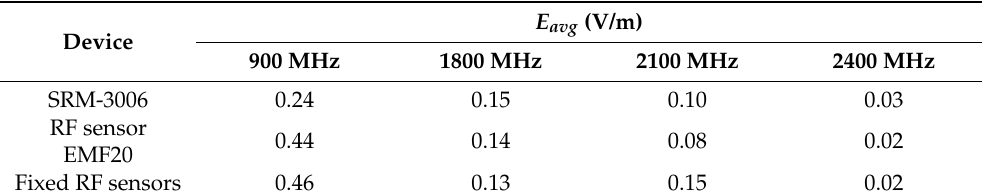
Table A1. Average electric field values measured by three different setups (SRM-3006 at ground level, RF sensor EMF20 at ground level, and the fixed RF sensors) during the fixed-sensor validation.